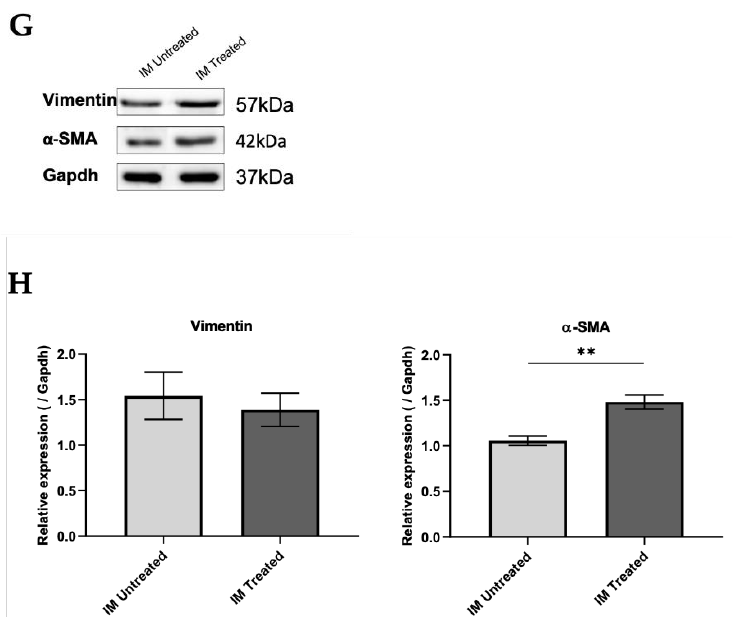
Figure 4. Conditioned medium from BLM-sorted IM induce fibroblasts proliferation and differenti- ation into myofibroblasts. ( A ) Experimental design. After CD45 enrichment, IM were sorted from dissociated lung samples on day 7 after saline (IM untreated) or BLM (IM treated) administration and cultured for 24 h to collect the CM. MLg, a fibroblast cell line, was cultured with control medium, conditioned medium from untreated IM, or treated IM. After 48 h, the ( B ) metabolic activity was measured by MTS assay, ( C ) cell proliferation by Ki-67 staining, and ( D ) respective quantification was performed. Differentiation state was analyzed by ( E ) immunofluorescence with vimentin (red) and α -SMA (green), nuclei are stained with DAPI (blue), and ( F ) respective quantification, also by ( G ) Western blot, and ( H ) quantification of relative expression. Scale bar = 200 µ m. Original magnification, 100 × . Data are shown as the mean ± SEM of one representative experiment of three independent experiments. ** p < 0.01, *** p < 0.001: treated IM vs. treated AM.